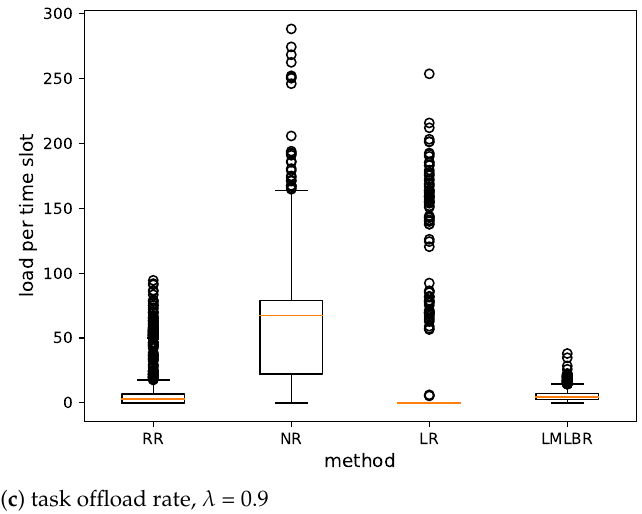
( c ) task offload rate, λ = 0.9 Figure 2. Load per time slot of four